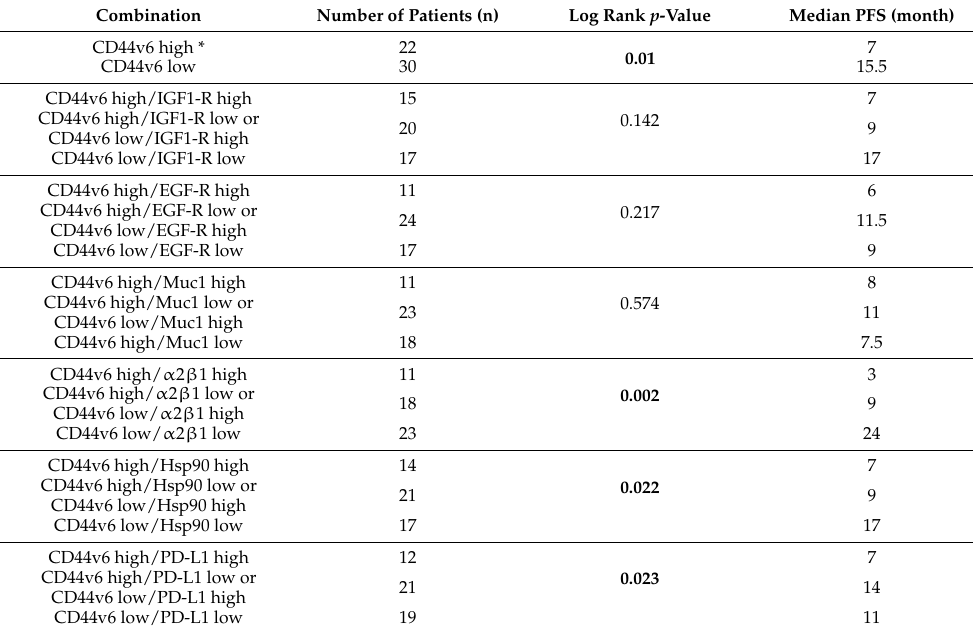
Table 5. Univariate Survival Analysis of CD44v6-Related Dual Biomarker Expression in Colorectal Liver Metastases.